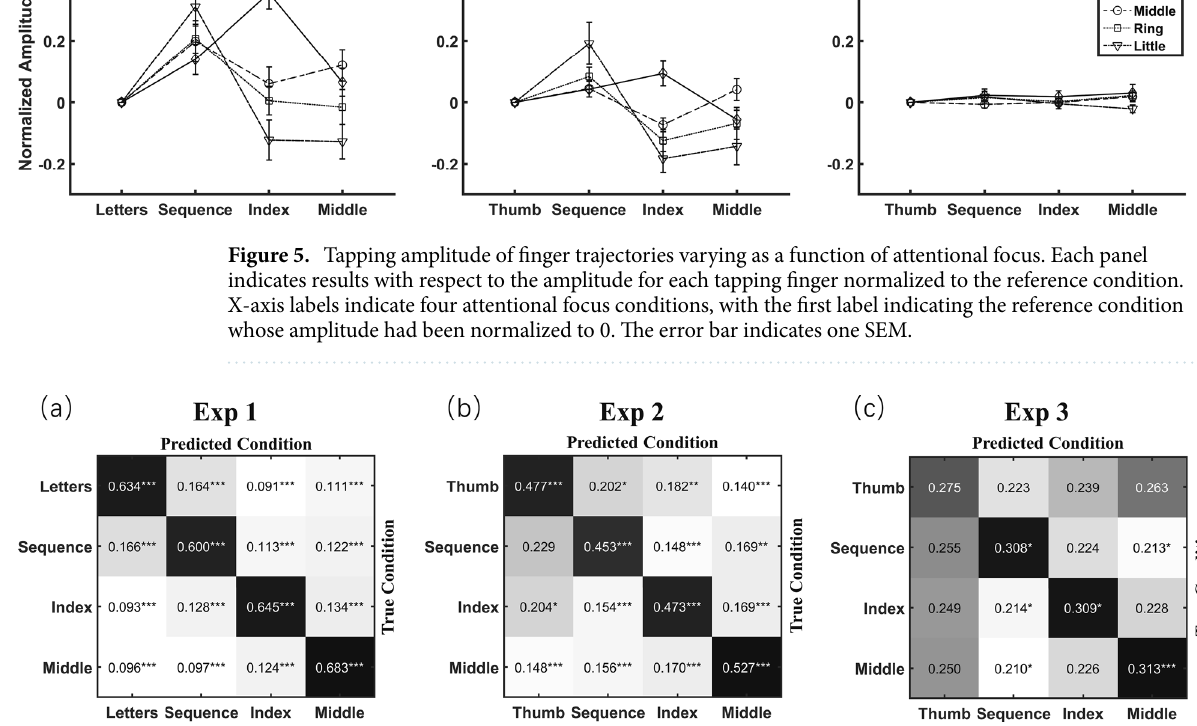
Figure 6. Distinct patterns of automatic movements varying as a function of attentional focus . For each panel and cell, the value corresponds to the ratio of samples of the true condition, which were classified as the predicted condition. Statistics were conducted against the chance level (0.25) by using a one-sample t-test. Darker cells indicate values above chance while whiter cells indicate values below chance. *, p < 0.05, ***, p <